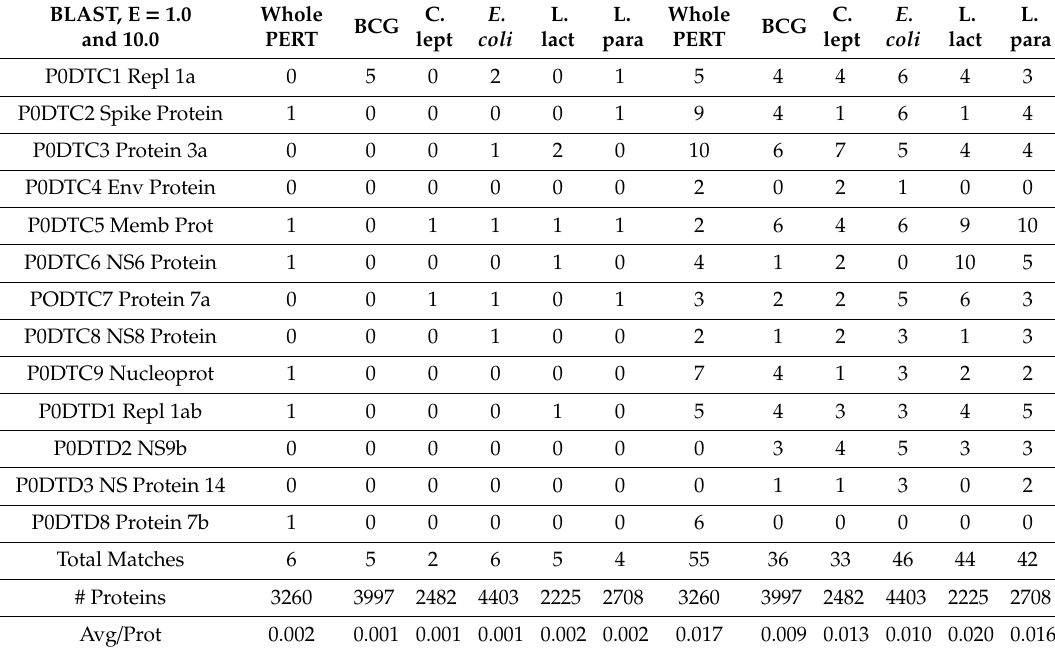
Table 4. Summary of BLAST search result matches between SARS-CoV-2 proteins (left-hand column) and whole bacteria at E = 1.0 (shaded left-hand columns) and E = 10.0 (unshaded